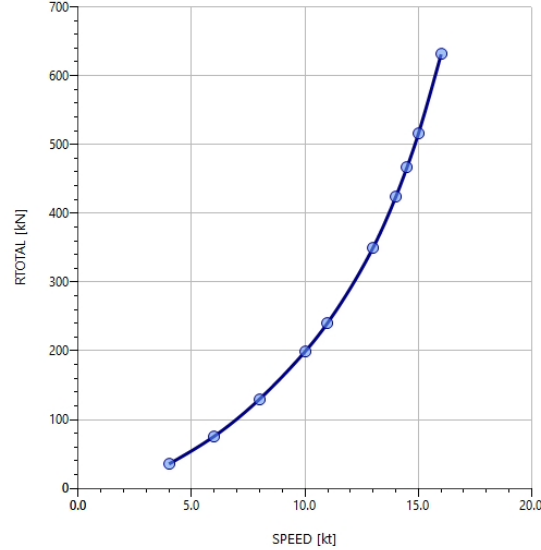
Figure 3. Total ship resistance at different speeds.